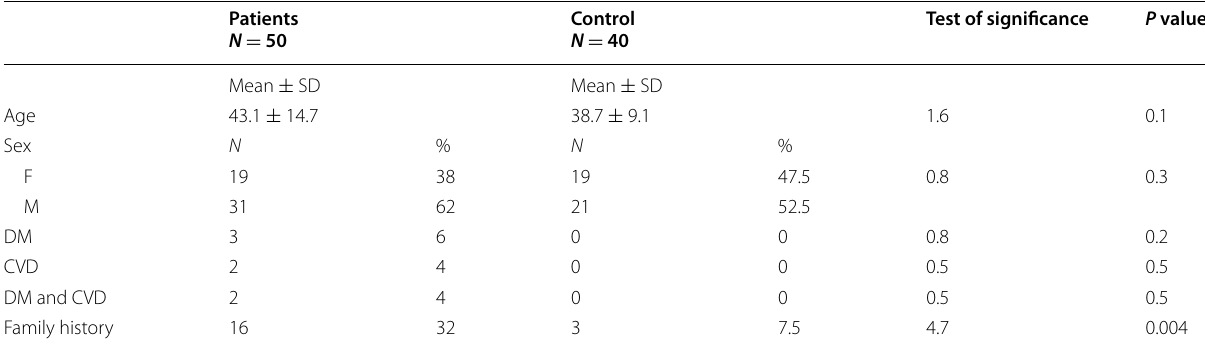
D.M diabetes mellitus, CVD cerebrovascular